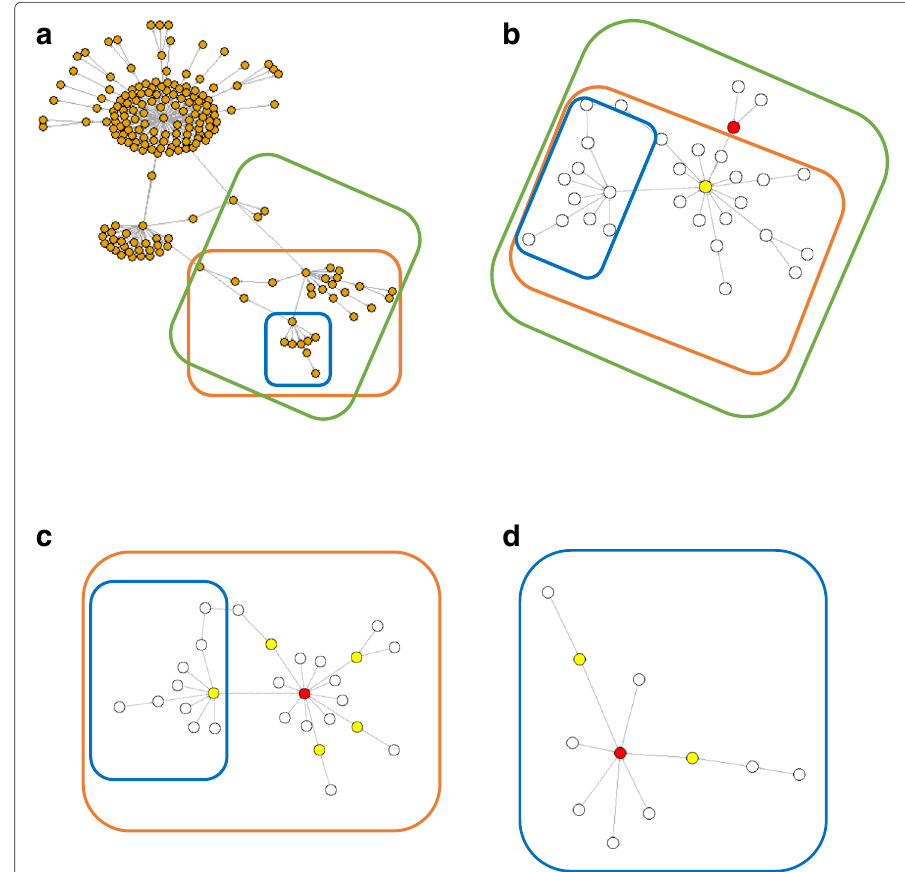
Fig. 5 Example of Google. a shows all Google’s affiliates. b - d show the result of calculation in the first-third layers, respectively. A company whose holding centrality H exceeds 0 is painted in red and a company whose conduit centrality C exceeds 0 is painted in yellow. Green, orange, and blue rectangles show the first-third layer,